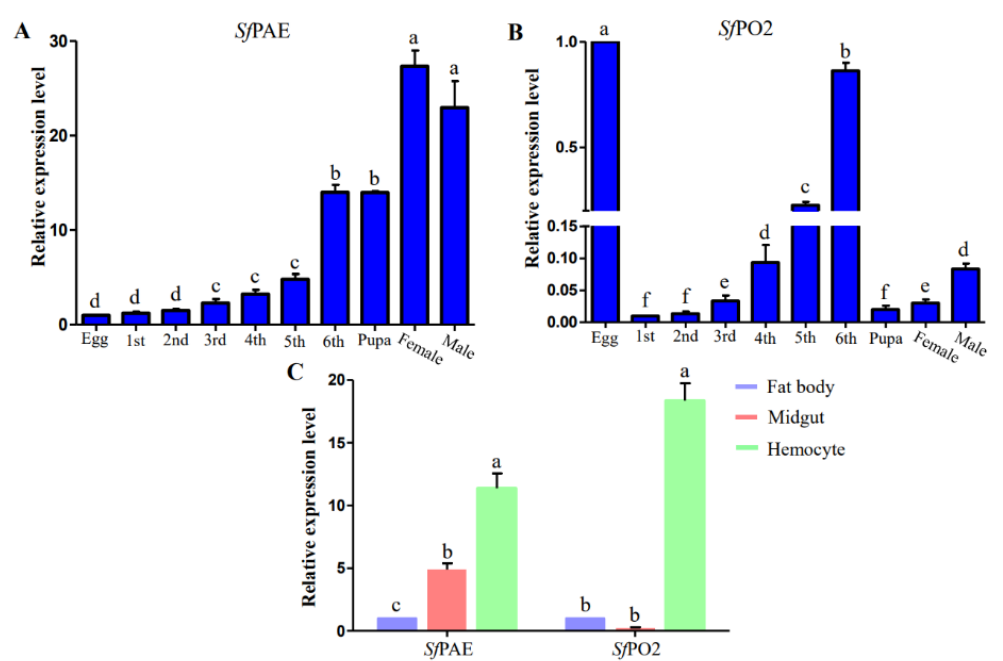
Figure 2. qRT-PCR measurement of Sf PAE and Sf PO2 expression at different time points during the life cycle of S. frugiperda. ( A ) Sf PAE gene, ( B ) Sf PO2 gene. qRT-PCR measurement of Sf PAE and Sf PO2 expression at different tissues ( C ). Bars with the same letter are not significant, and different letters indicate a significant difference from each other at p < 0.05 based on Tukey’s test.